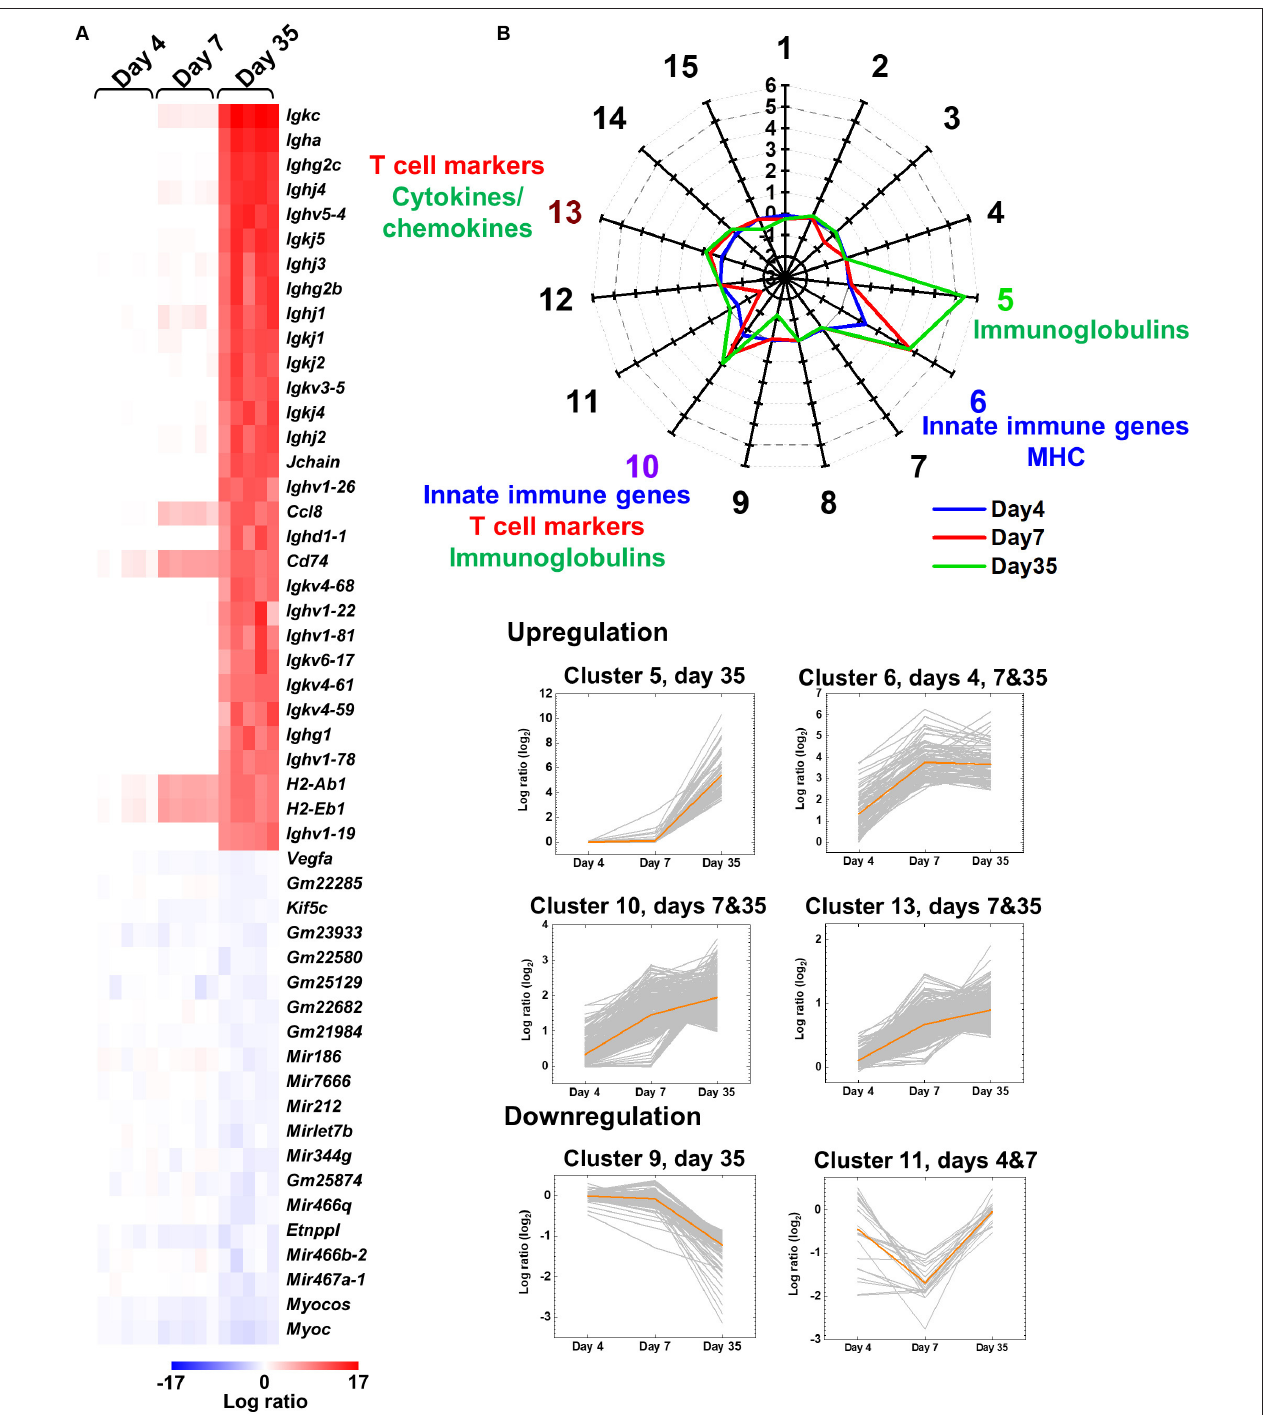
FIGURE 1 | Central nervous system (CNS) transcriptome data of mice infected with Theiler’s murine encephalomyelitis virus (TMEV). (A) We harvested the spinal cord from five TMEV-infected mice per day and analyzed the gene expression patterns compared with five control mice. We drew the heat map of the top 30 genes up- or the 20 genes downregulated in the spinal cord of TMEV-infected mice on day 35 compared with those on days 4 and 7 by the R packages “gplots” and “genefilter.” Red, blue, and white indicate upregulation, downregulation, and no change, respectively. Humoral immunity-related genes, including immunoglobulin (Ig) heavy ( Igh ), light [kappa ( Igk ) and lambda ( Igl )], and J ( Jchain ) chains, were highly upregulated in TMEV-infected mice on day 35. Lists of significantly up and downregulated genes in TMEV-infected mice were shown in Supplemental Table 2 and Supplemental Figure 1 . (B) Radar chart of cluster centers calculated by k -means